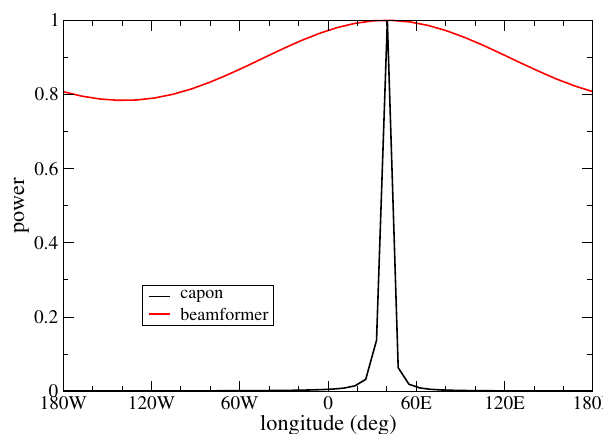
Fig. 1. Comparison between the beamformer (red) and the Capon (black) techniques for one plane wave detected with a regular tetra- hedron